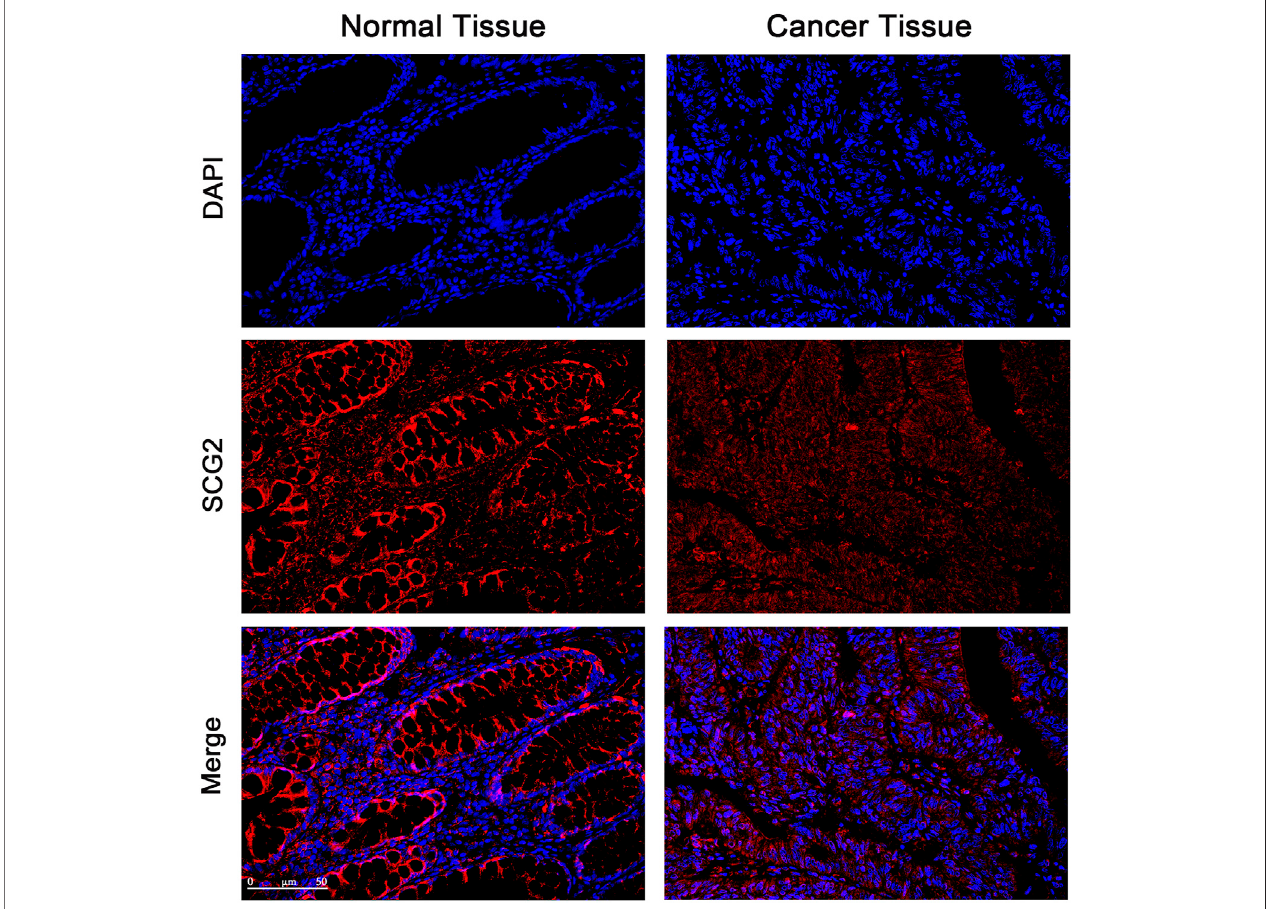
FIGURE2| Immuno fl uorescenceimagesofSCG2(red)andDAPI(blue)intumor andadjacenttissuesofCRC patients.Sevenpairsoftumorsandadjacenttissues were examined, six of the tumor tissues showed deceased SCG2 expression compared to adjacent normal tissues.